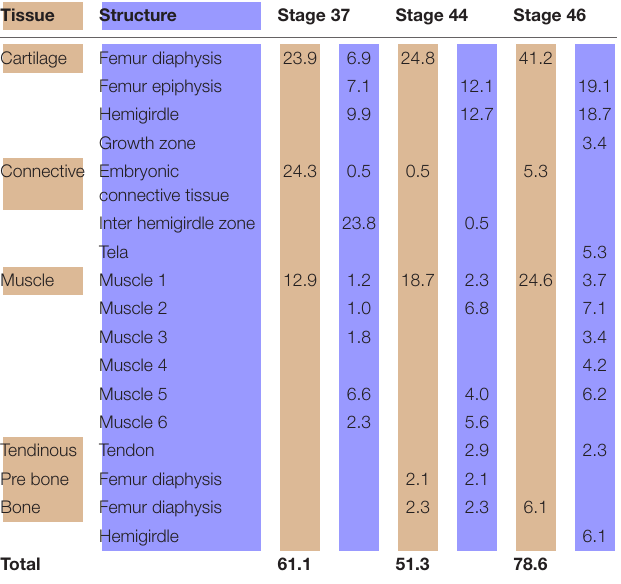
TABLE 2 | Tissues (light brown) and structures (light blue) percentages (%) in relation to the analyzed area ( Boana riojana ). Tissue Structure